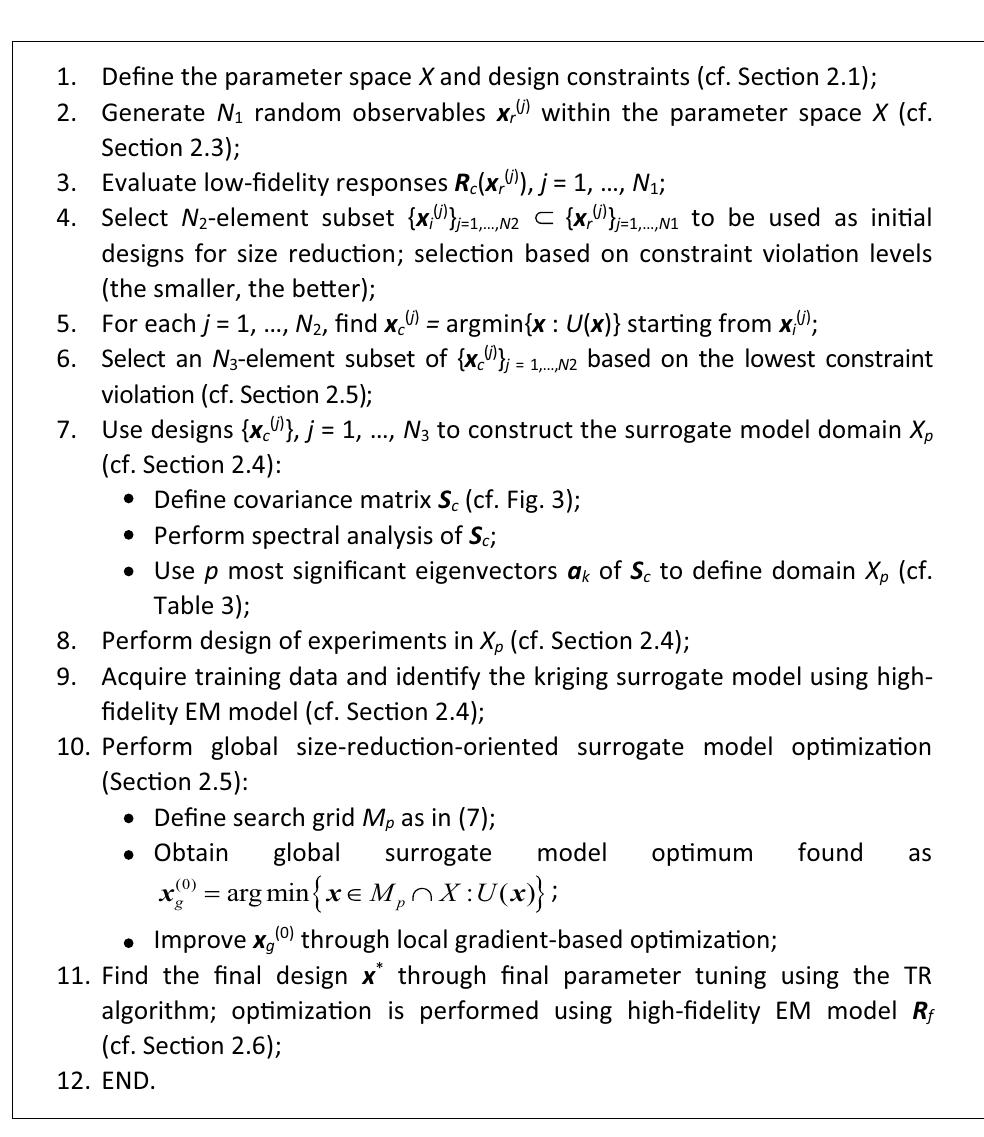
Figure 7. Operating flow of the proposed globalized size reduction